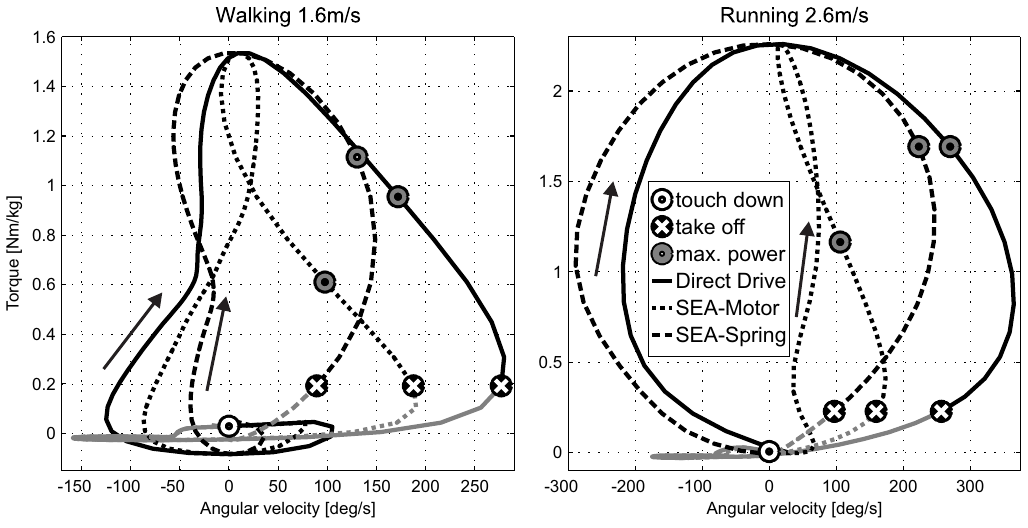
Figure 6. Ankle torque: angular velocity curves for walking at 1.6 m/s and running at 2.6 m/s. The solid line represents human data, which is similar to that for a direct drive. The dotted line represents data for the SEA motor and the dashed line data for the SEA spring. Stance phase is indicated by a black line and flight phase by a grey line. The stance phase starts with touch-down and ends with take-off. The maximum power during push off is indicated for each case. Arrows indicate the path direction during the gait cycle. The series spring helps to reduce motor velocity, resulting in lower peak